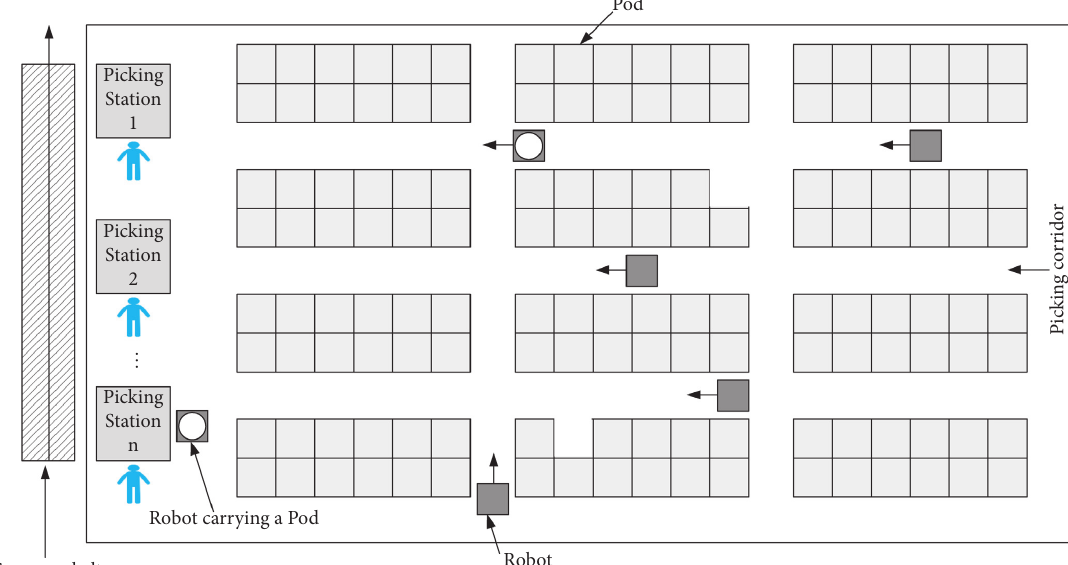
Figure 1: The typical layout of an